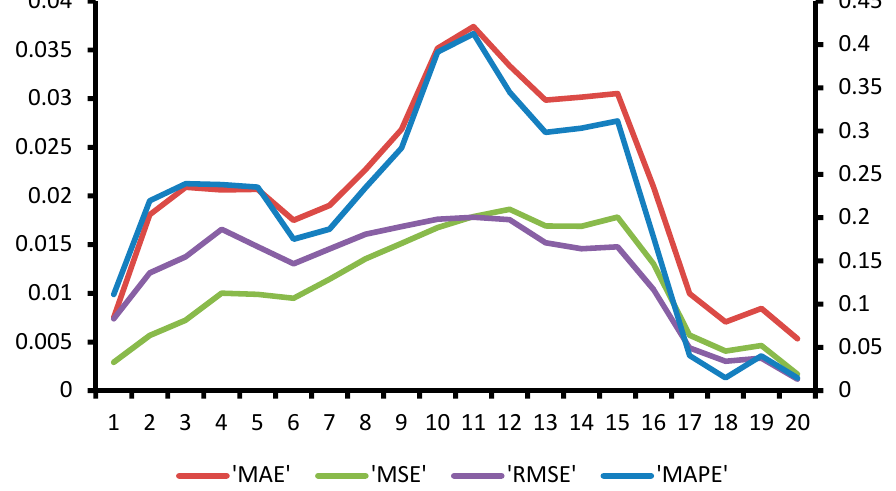
Figure 7. Differential errors between predictions when using prices of CO 2 emission allowances only and when the iron and steel price trend is also used as an input variable.